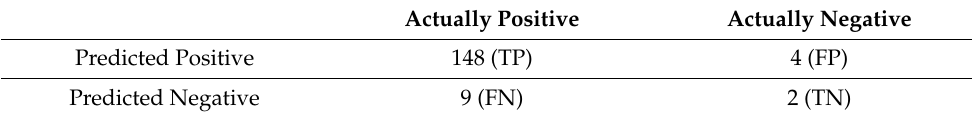
Table 2. Confusion Matrix.